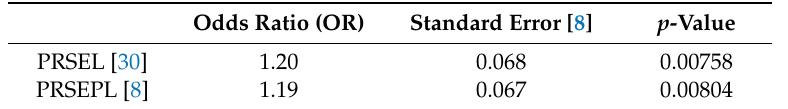
Table 3. Associations between longevity EL and EPL PRS ( p -value threshold < 5 × 10 − 5 ) and exceptionally long-lived cases versus